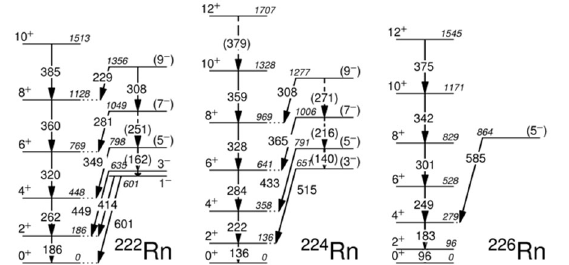
Figure 3. Level schemes. These partial level-schemes for 222,224,226 Rn show the excited states of interest. Arrows indicate γ -ray transitions. All energies are in keV. Firm placements